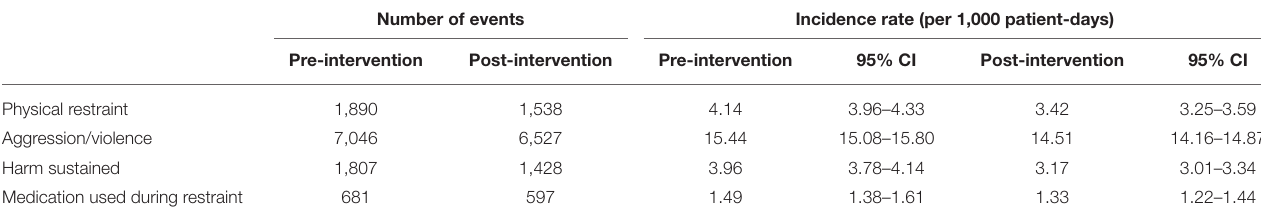
TABLE 3 | Incidence rates and number of events of physical restraint, aggression/violence, harm sustained, medication used during